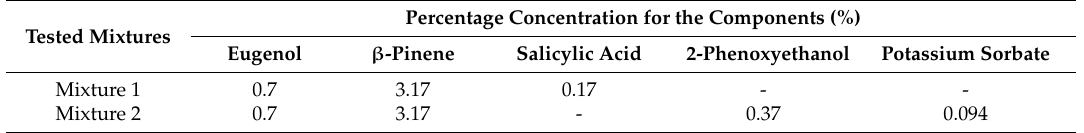
Table 5. Receipt of tested formulations for the calculation of